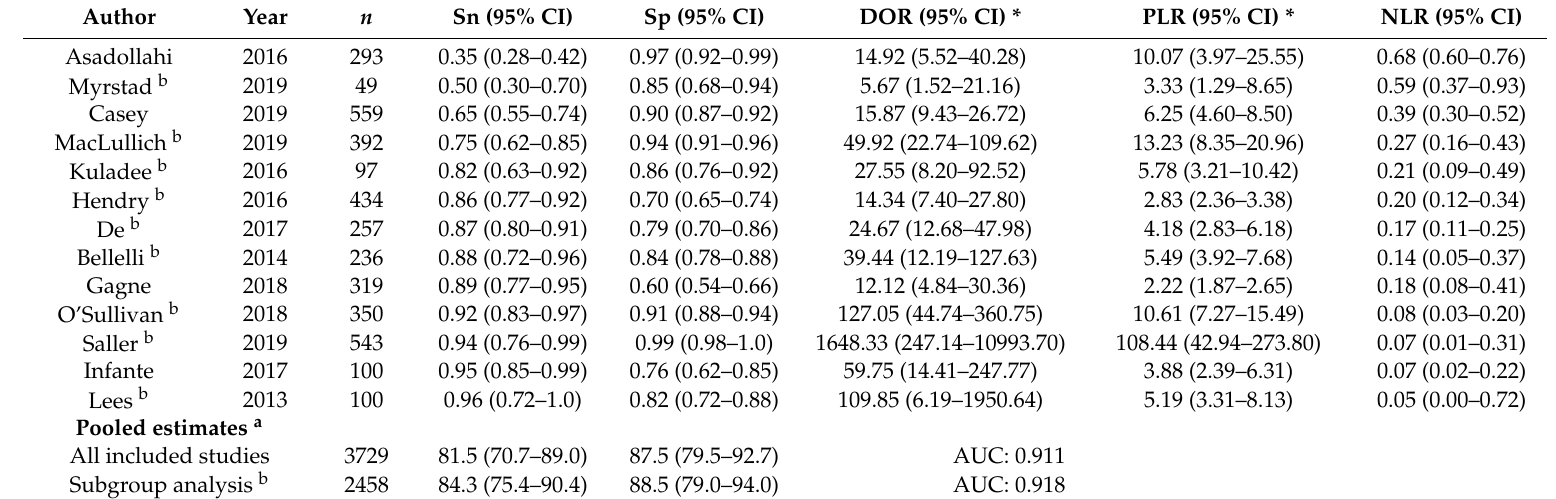
Table 3. Diagnostic test accuracy of the included